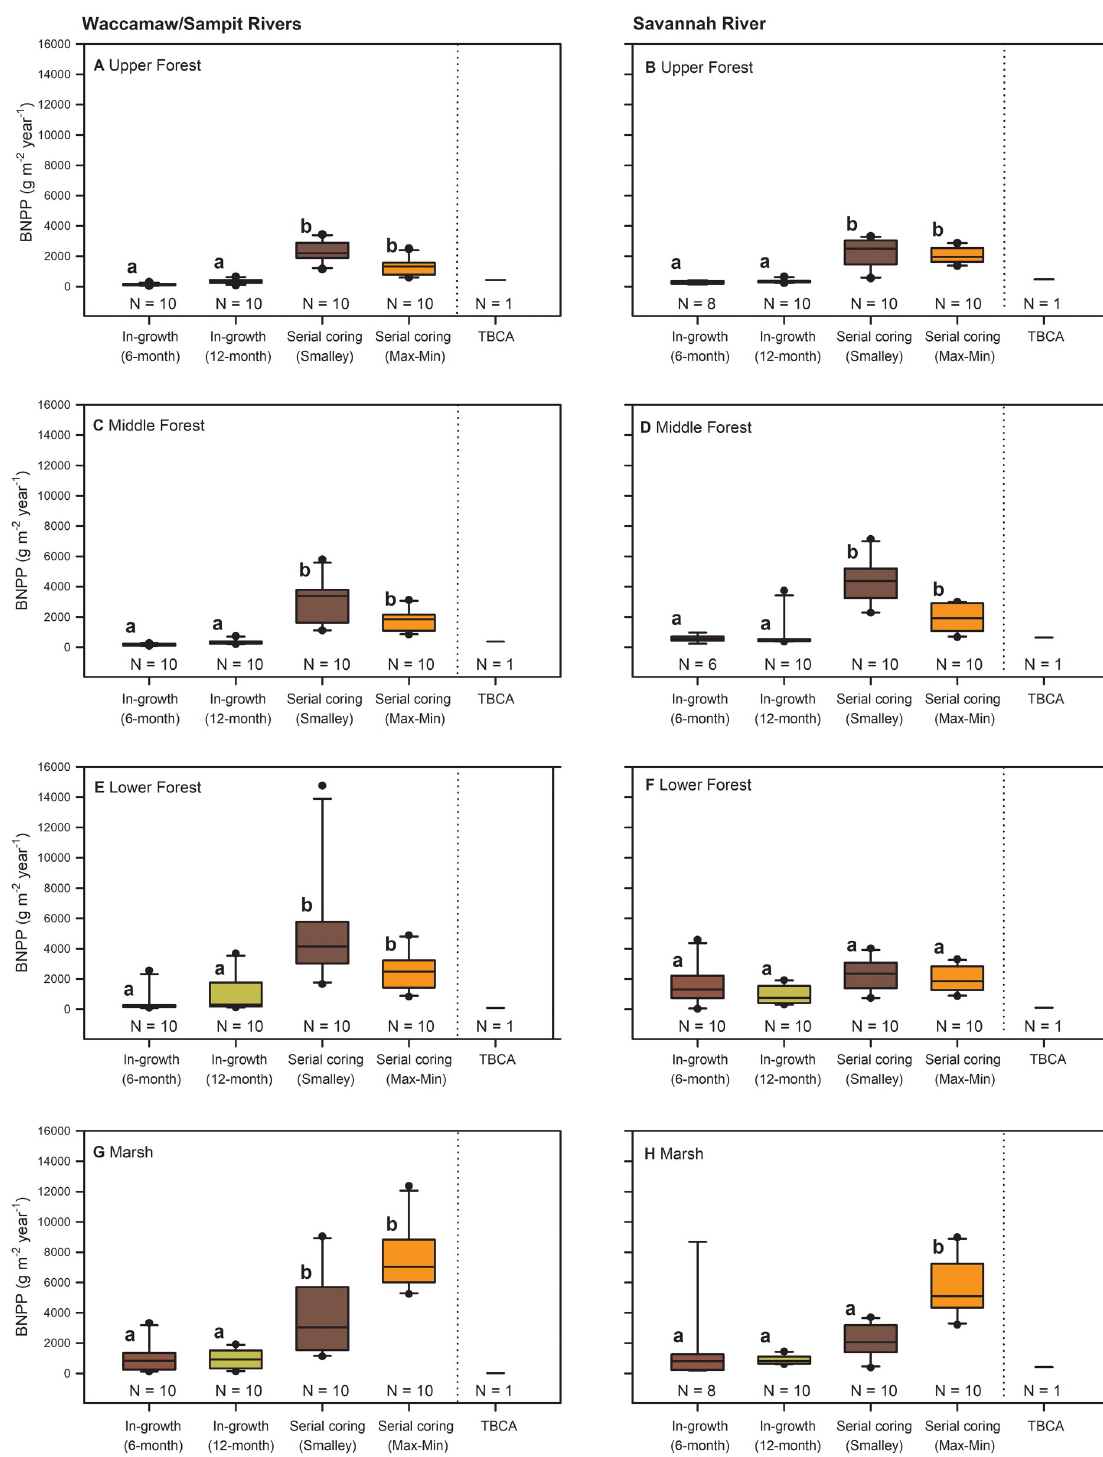
Fig 3. Belowground net primary productivity (BNPP, median) by technique and site for TFFW and marshes. BNPP was estimated using root ingrowth techniques over 6 months, root ingrowth techniques over 12 months, Smalley estimation of serial coring data, Maximum-Minimum (Max-Min) estimation of serial coring data, and total belowground carbon allocation (TBCA) for data collected from TFFW transitioning to marsh along the Waccamaw/Sampit Rivers, South Carolina, (A), Upper Forest, (C) Middle Forest, (E) Lower Forest, and (G) Marsh; and along the Savannah River, Georgia, (B), Upper Forest, (D) Middle Forest, (F) Lower Forest, and (H) Marsh. Mean values by technique and site followed by the same letter within a river do not differ significantly (Technique × River × Site, n.s.; Technique × Site, F 9,280 = 4.91, P <